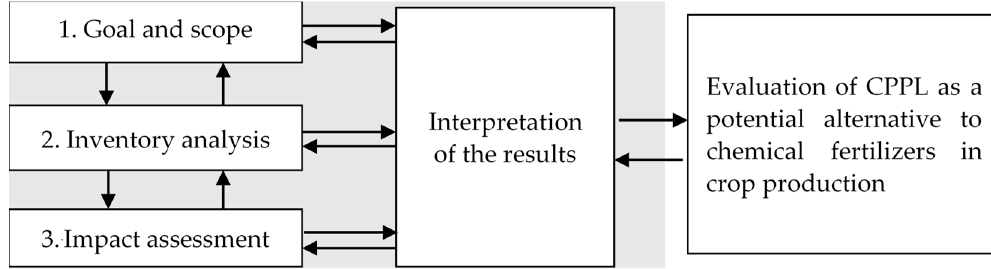
Figure 1. Steps of life cycle assessment (adopted from ISO14040:2006 [53]).